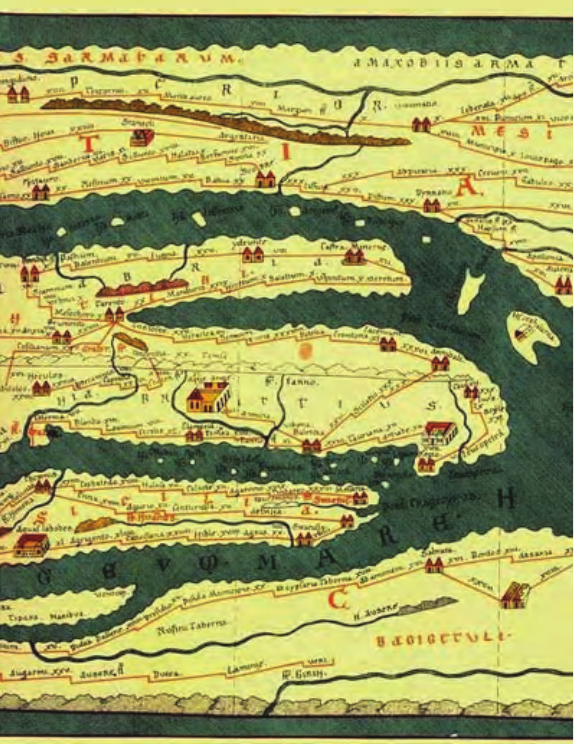
Fig. 4. Kastorijus map or the roauds of the Roman Empire